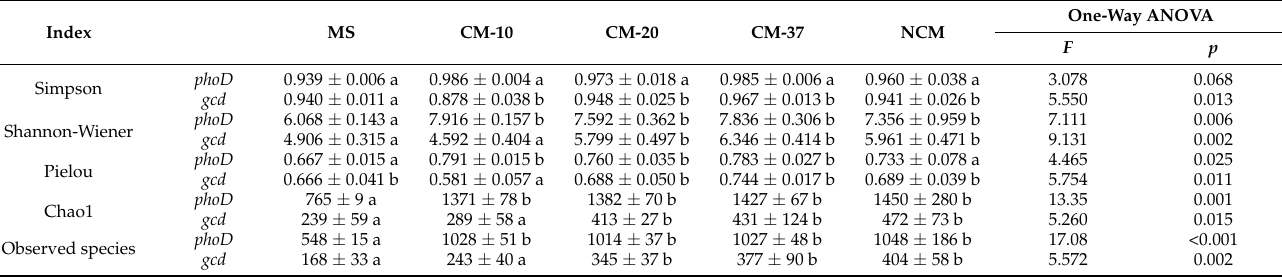
Values are means ± SD. MS: moving sand dune (0-yr); CM-10, CM-20, and CM-37: 10-, 20-, and 37-year plantation, respectively; NCM: natural C. microphylla community. F , and p -values from One-way ANOVA are given. Means in rows followed by different letters are significantly different ( p <